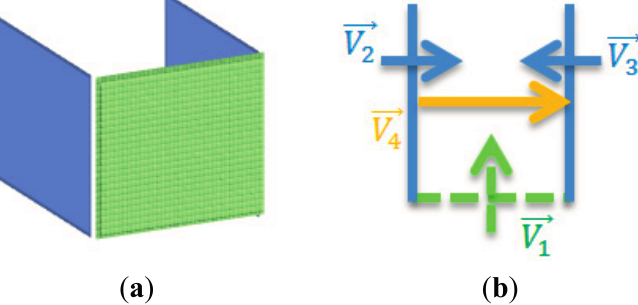
Figure 10. The structure common in both two types of circuit breakers consisting of a